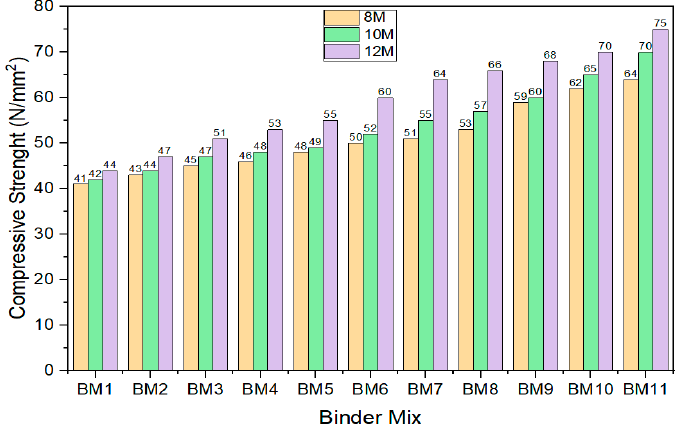
Figure 8. GP mortar compressive strength under oven-curing.